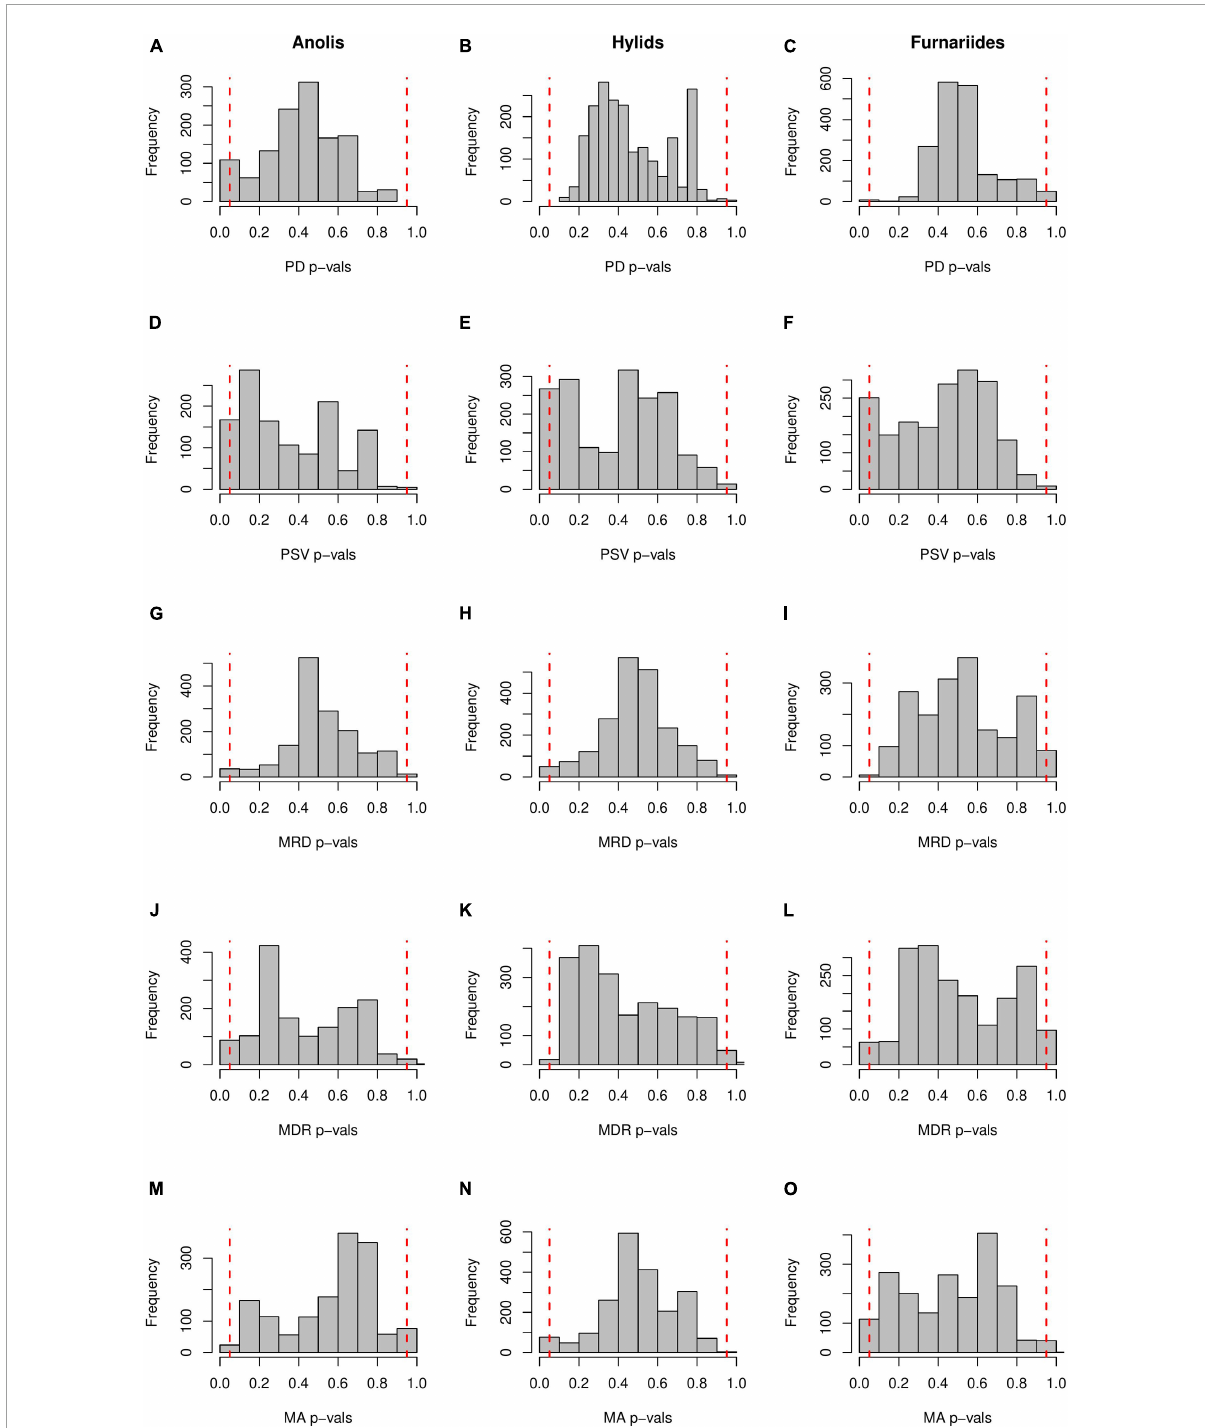
FIGURE2 P -values for each phylogenetic metric obtained through null models. Histograms show the frequency distribution of p -values of Anolis lizards (left-panels A,D,G,J,M ), hylid frogs (mid-panels B,E,H,K,N ), and Furnariides birds (right-panels C,F,I,L,O ). Vertical dashed red lines represent the low (metric value ≤ 0.05) and high (metric value ≥ 0.95) quantile values of the metrics expected under the null model. For example, high quantiles of phylogenetic diversity (PD p -vals ≥ 0.95) mean greater phylogenetic diversity among co-occurring species than expected by the null model, whereas low quantiles of phylogenetic diversity (PD p -vals ≤ 0.05) mean lower phylogenetic diversity among co-occurring species than expected under the null model. The null model used in this study was the ‘independentswap’ randomization algorithm that randomizes the observed presence-absence matrix while maintaining species occurrence frequency and species richness per grid-cell. See “Methods” section for more